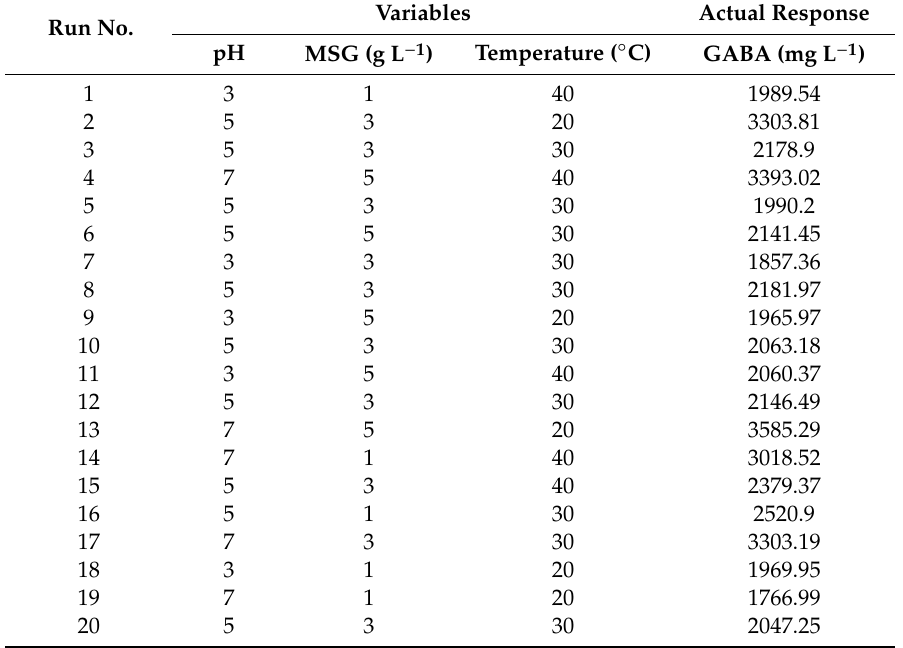
Table 2. Central composite design (CCD) design with studied variables and actual responses for the gamma-aminobutyric acid (GABA) production (mg L − 1 ) of B. cereus KBC. Run